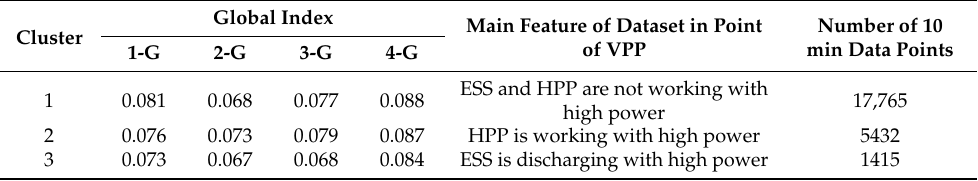
Table 4. Qualitative assessment between clusters and main defining